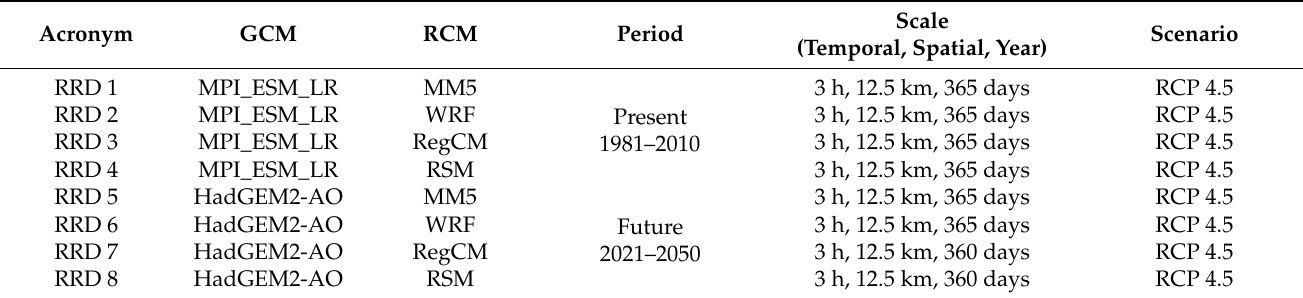
Table 1. The 8 RCMs used from the KOR-11.